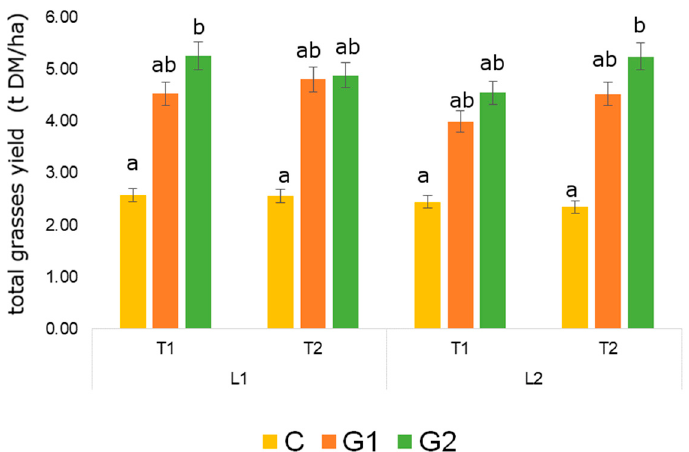
Figure 4. The total shoot yield of grass mixture from the control plots (C) and plots fertilized with sewage sludge in a dose of 14.5 t DM/ha (G1) and 29 t DM/ha (G2) in L1 and L2, collected in first (T1) and second (T2) year of study. The different letter above bars (mean ± SD) represented significant differences assessed with the Tukey test at p < 0.05.